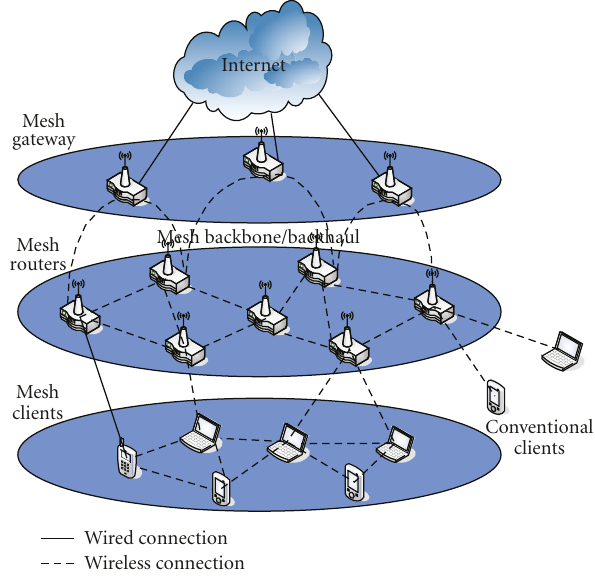
Figure 1: Wireless Mesh